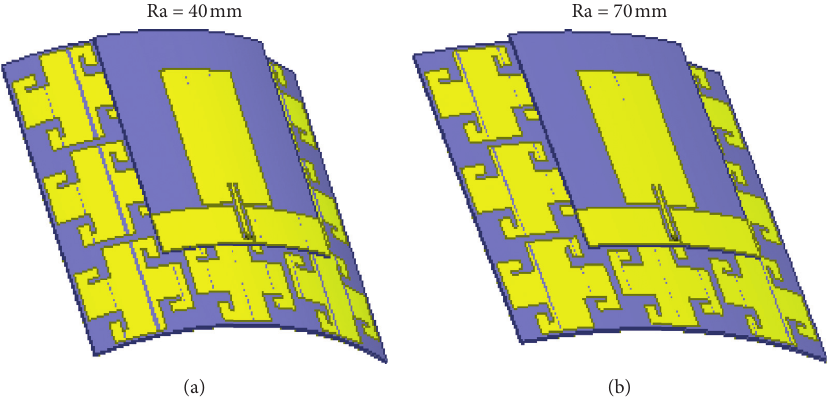
Figure 8: Structure deformation integrated MSs antenna with varying values of radius: (a) Ra � 40 mm and (b) Ra � 70mm.